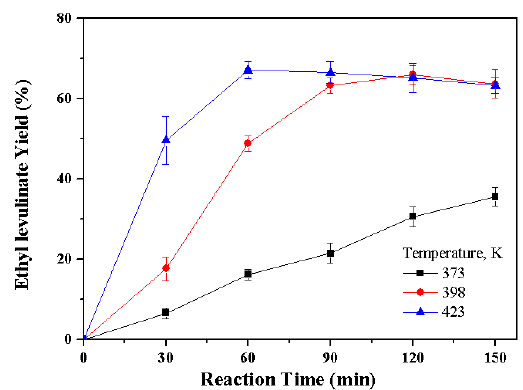
Figure 3. E ff ect of reaction temperature on EL yield. Reaction conditions: furfuryl alcohol (FA) 1 g, ethanol 19 g, GCC 0.5 g.